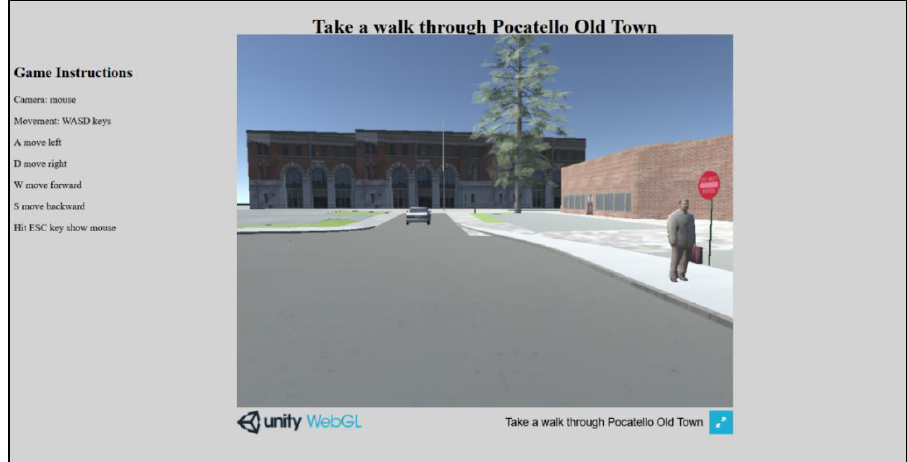
Figure 9. Unity WebGL walking game in a Firefox browser window.